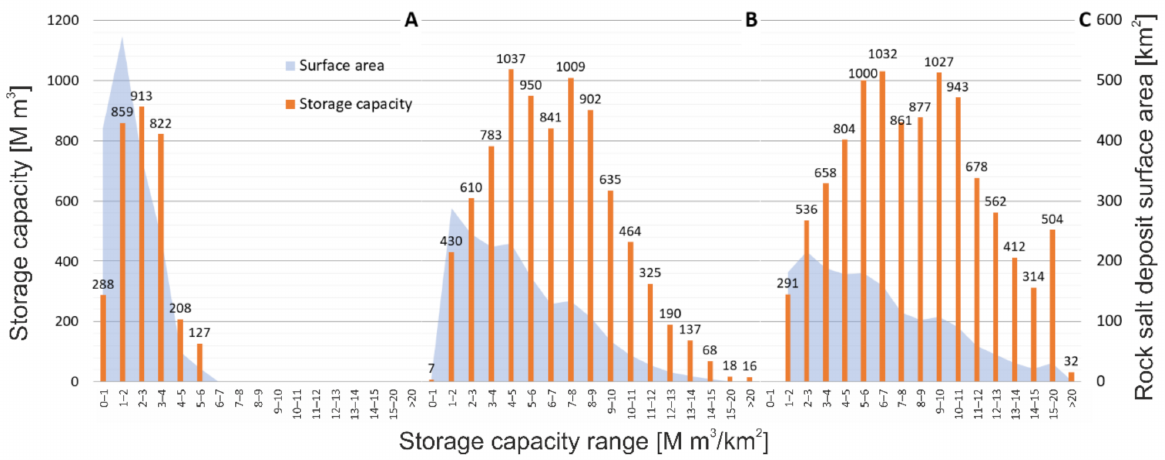
Figure 11. The analysis results of the unique raster values of liquid fuel storage capacity (( A ) initial state of operational storage, ( B ) target state of operational storage, ( C ) strategic